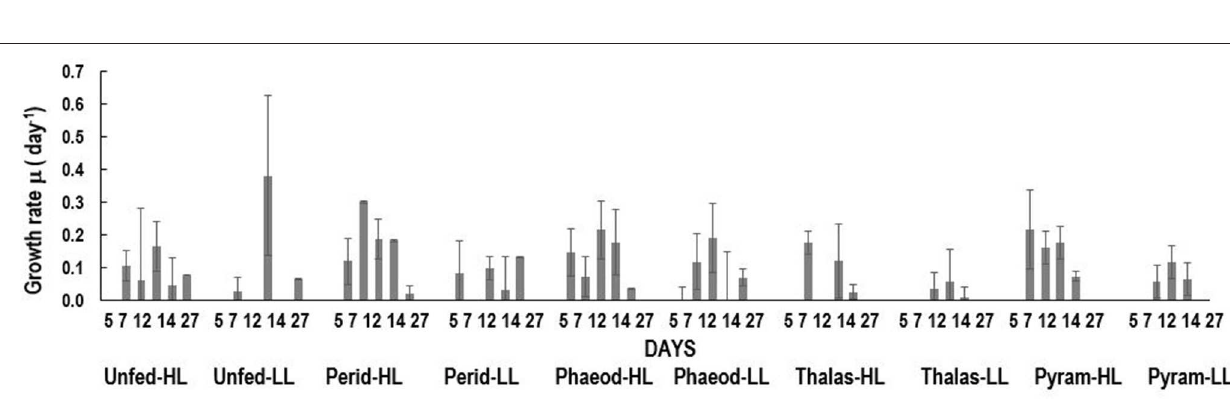
FIGURE 3 | “Growth rates (day − 1 ) over the course of the experiment for unfed Noctiluca and for Noctiluca fed P. foliaceum (Perid), P. tricornutum (Phaeod), T. weissflogii (Thalas), and Pyramimonas sp. (Pyram) and exposed to optimal (250 mE m − 2 s − 1 , HL) and low light (10 mE m − 2 s − 1 , LL). Data points represent means ± SE ( n = 2) (day − 1